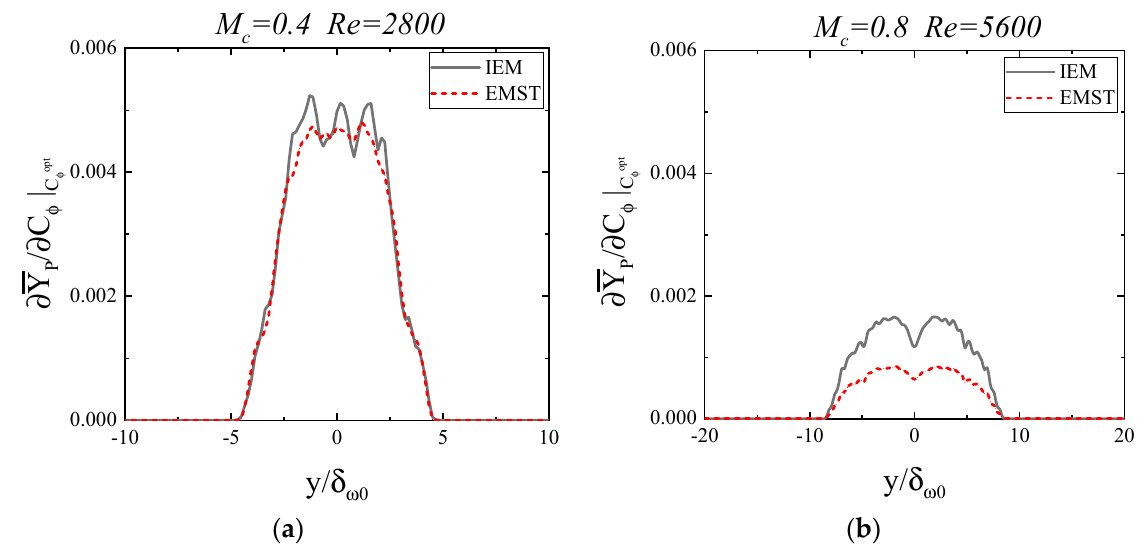
¯ Y at optimal mixing model coefficient C Y P at optimal mixing model coefficient C opt φ for ( a ) M c = 0.4 case P